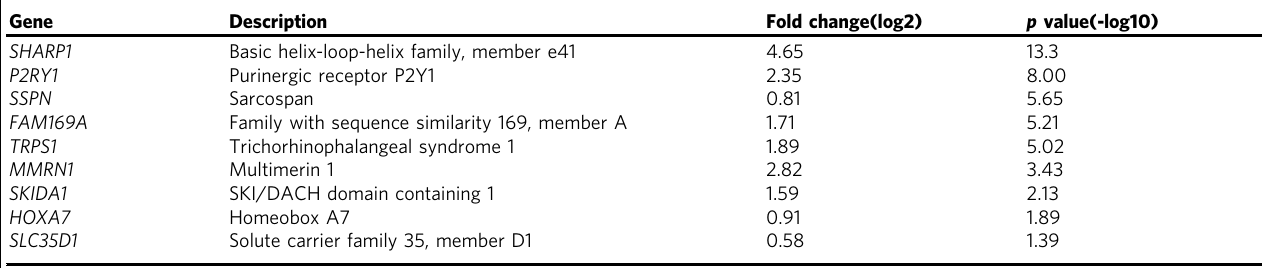
Table 1 MLL-AF6 speci fi c target genes Gene